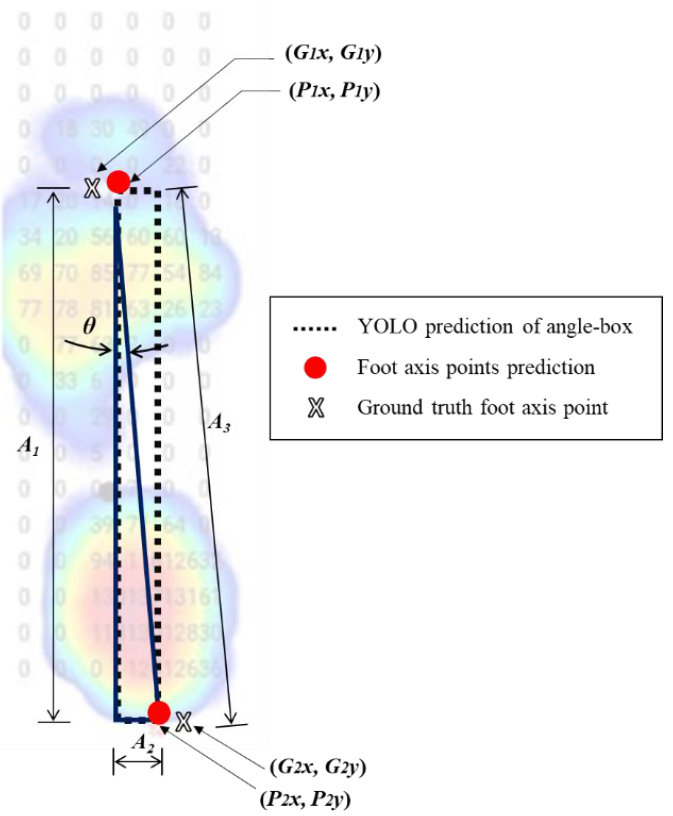
Figure 5. The example of diagonal foot progression angle (FPA) of the angle-box in the YOLO model; G 1 ( G 1 x and G 1 y ), Ground-truth for the front foot axis point; G 2 , ground-truth for the rear foot axis point in ( G 2 x and G 2 y ); P 1 ( P 1 x and P 1 y ), YOLO models prediction for front foot axis point; P 2 ( P 2 x and P 2 y ), YOLO models prediction for the rear foot axis point; A 1 , the height of angle-box; A 2 , the width of the angle-box; A 3 , the diagonal FPA of the angle-box; θ , in degrees for